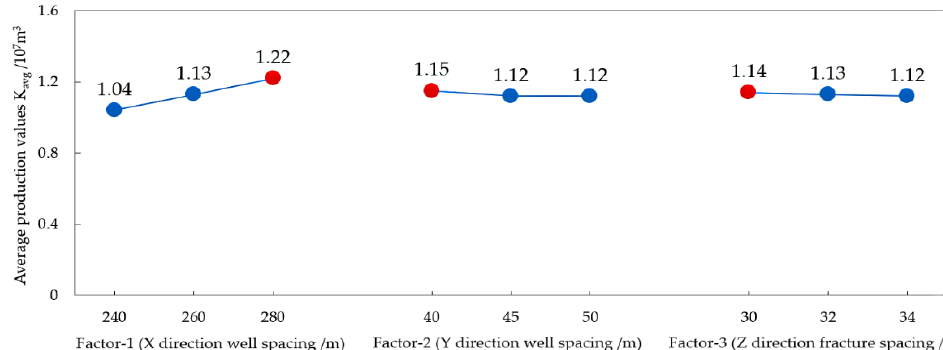
Figure 18. Mean value graph of each factor in vertical well.